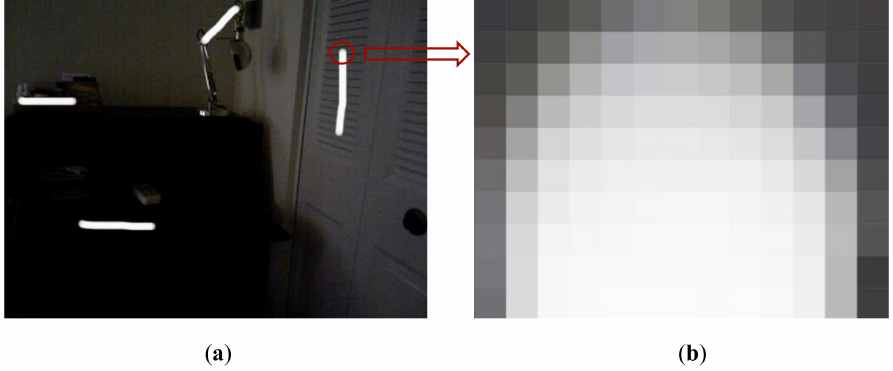
Figure 9. Input image. ( a ) Input. ( b ) Edge amplification result of damaged area.